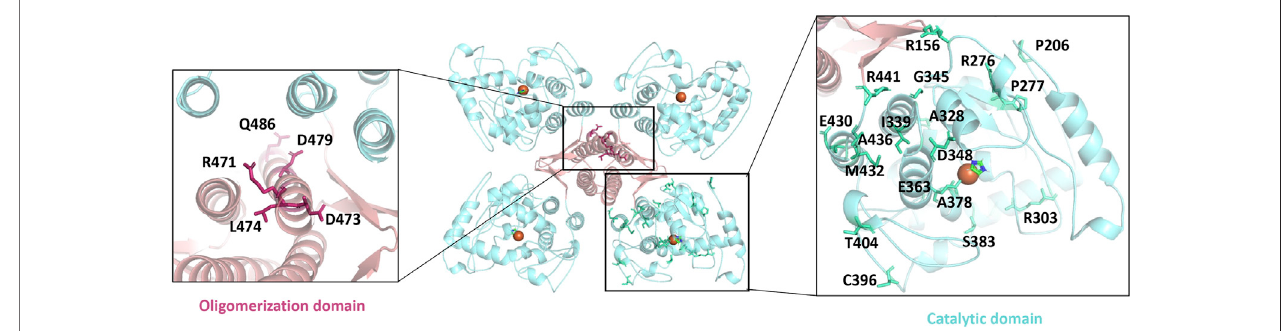
FIGURE5| Mappingthe disease-causingmutationson tryptophanhydroxylase2 structures. Theleft panel showsthe mutants oftheoligomerization domain,and the right panel shows the catalytic domain. All mutants are shown as sticks.